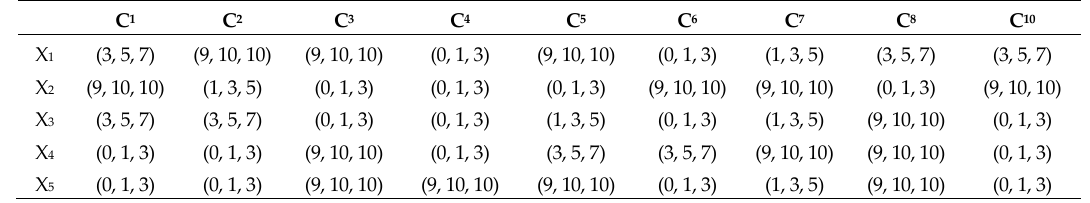
Table 9. Fuzzy decision